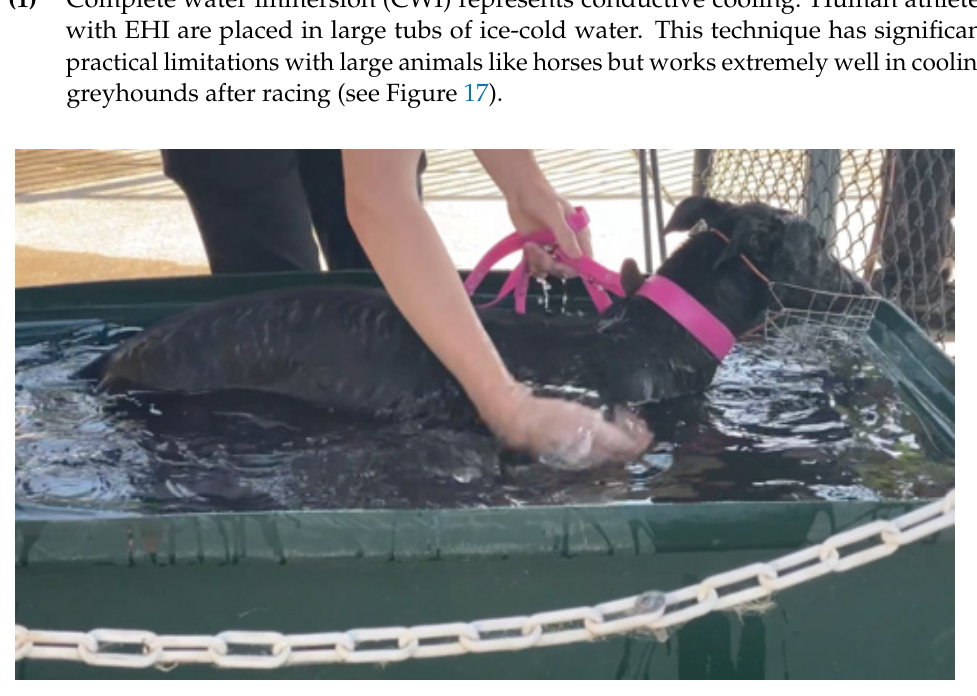
Figure 17. A greyhound in an immersion tub of cold water immediately after racing.